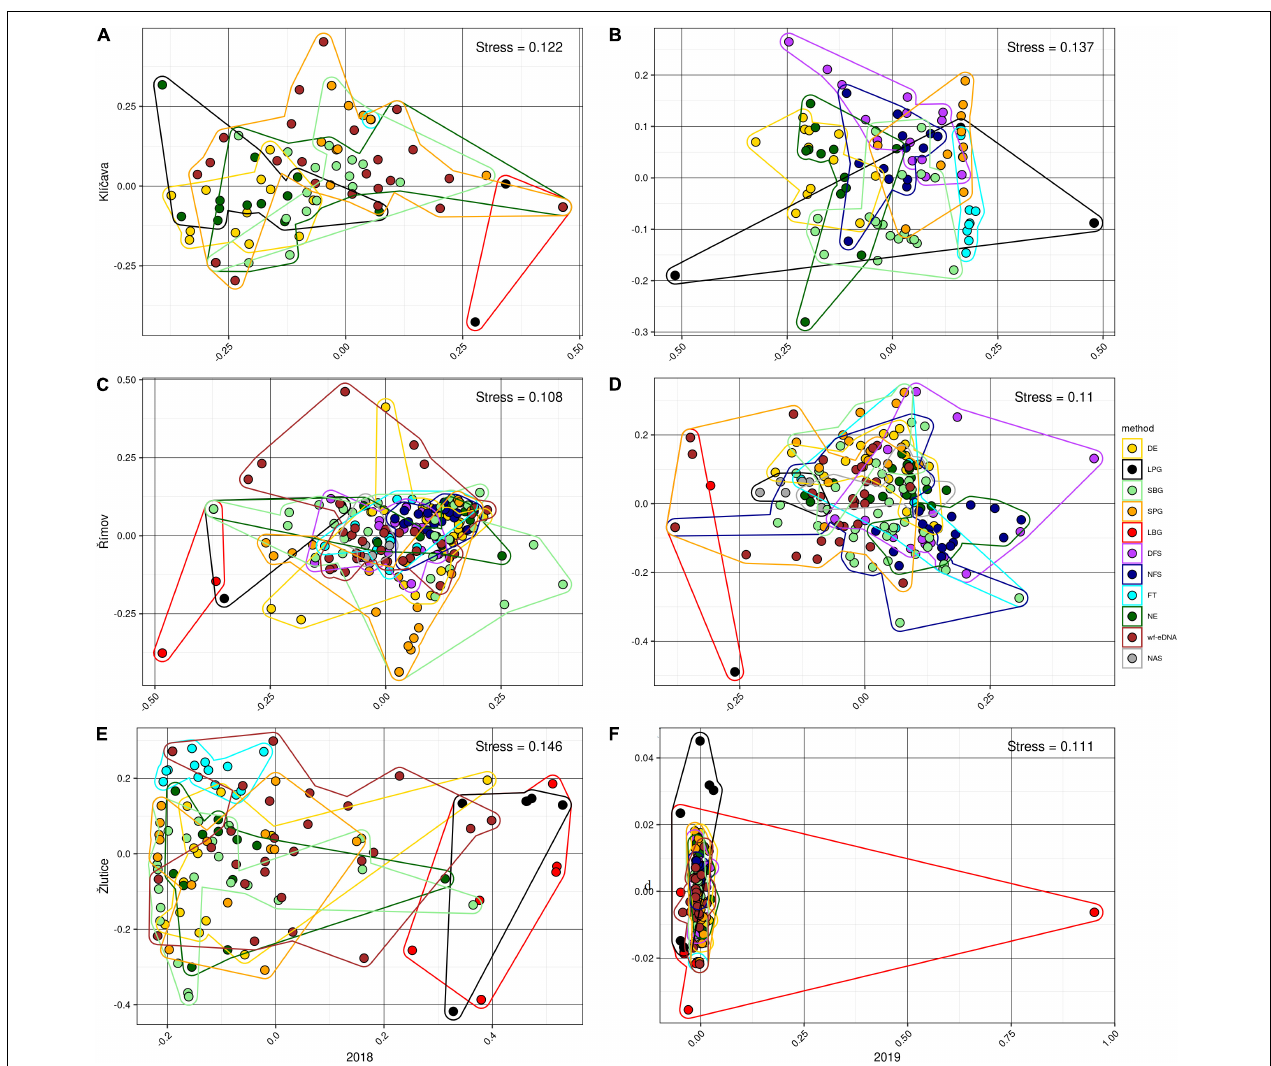
FIGURE 1 | Beta- diversity visualized using non-metric multidimensional scaling (NMDS) based on BPUE data in 2018 (left plots) and 2019 (right plots) with Bray-Curtis dissimilarity distances of community compositions for the wf-eDNA assay and traditional sampling methods in Klíˇcava, ˇRímov and Žlutice reservoirs. NMDS plots on rank order using Bray-Curtis distances were used to evaluate relationships based on intersample variation in estimated fish community composition between sampling methods. Plot ellipses represent the 95% confidence regions for the group clusters. Traditional sampling methods are abbreviated as follows: DE = day electrofishing, NE = night electrofishing, SBG = standard benthic gillnets, SPG = standard pelagic gillnets, LBG = large mesh-size benthic gillnets, LPG = large mesh-size pelagic gillnets, NAS = night-time adult seining, DFS = day-time fry seining, NFS= night-time fry seining, FT = fry trawl and wf-eDNA = eDNA from water targeting